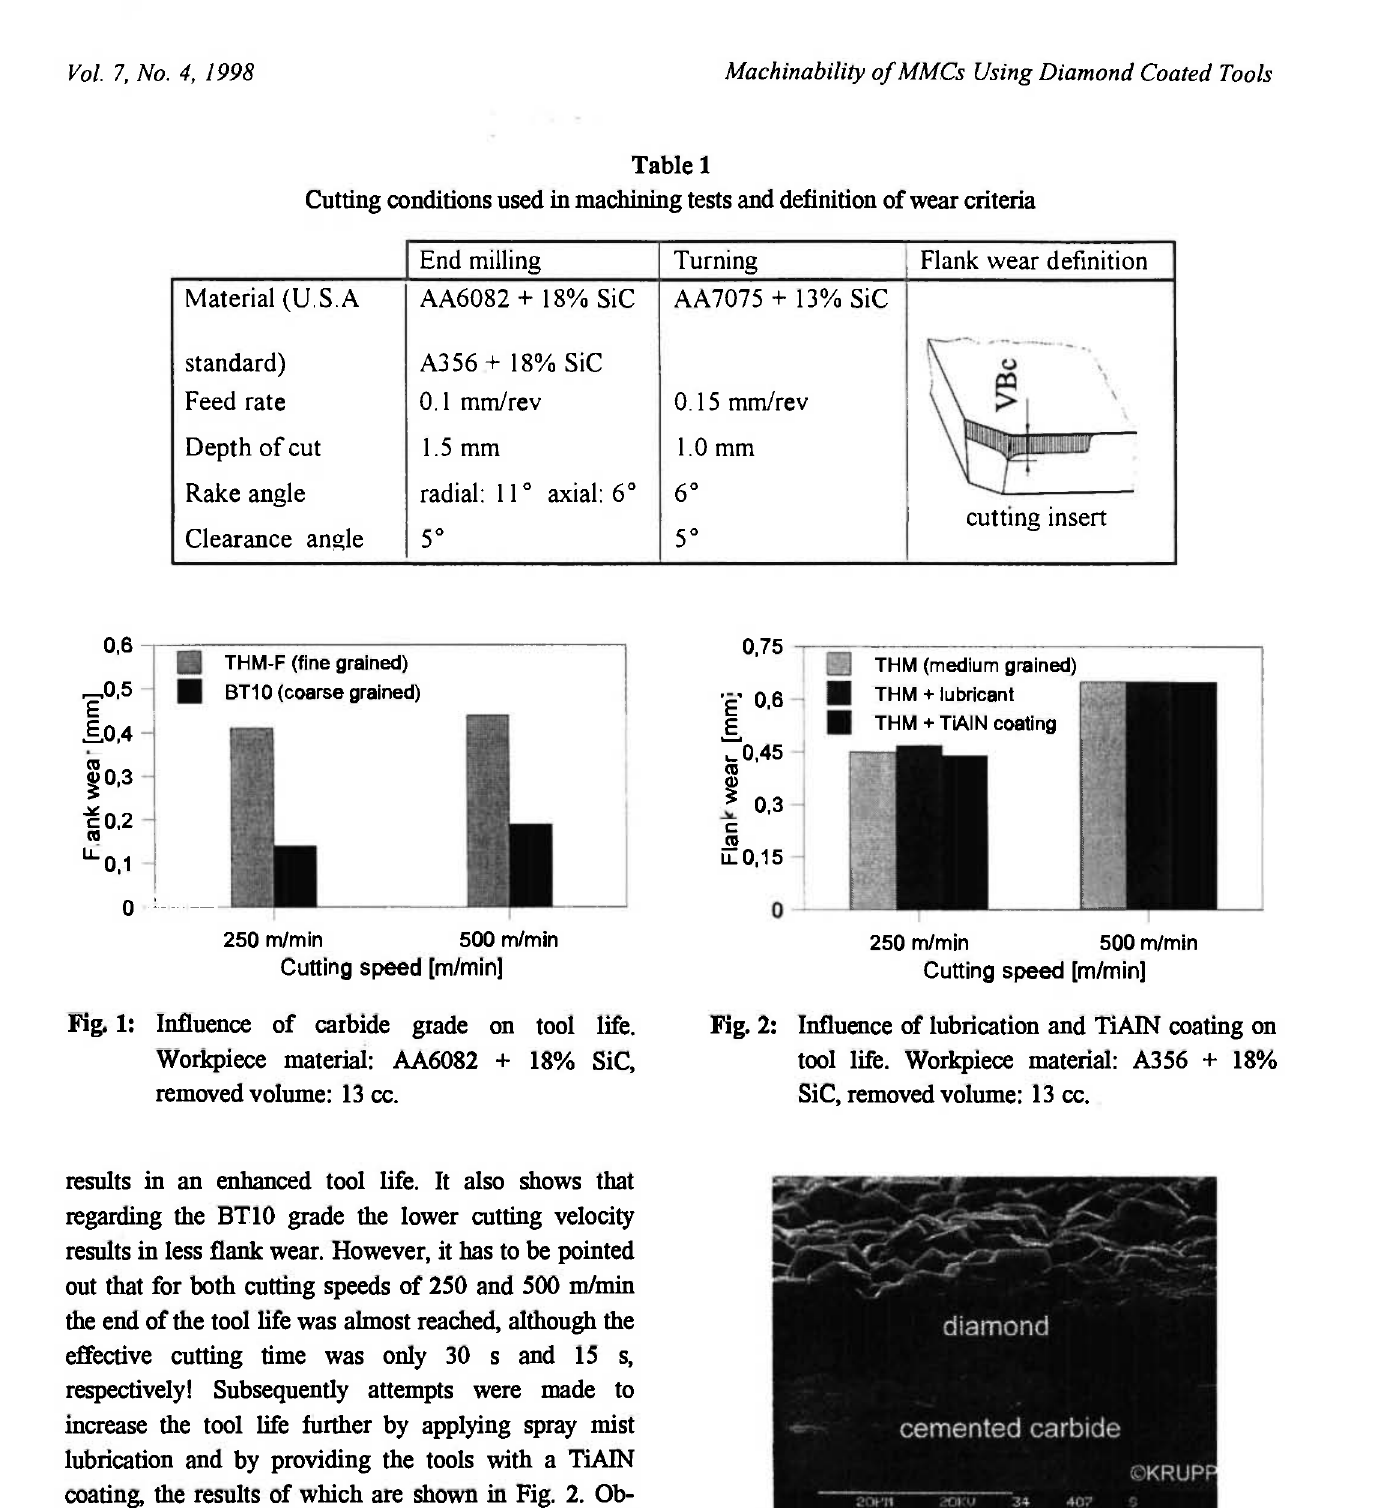
Fig. 3: Cross-sectional view of CVD deposited on cutting tool /4/.